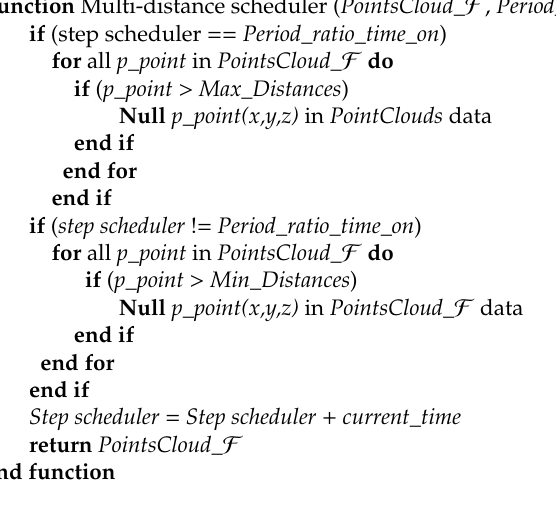
Table 1. Psuedocode for a multi-distance scheduler.